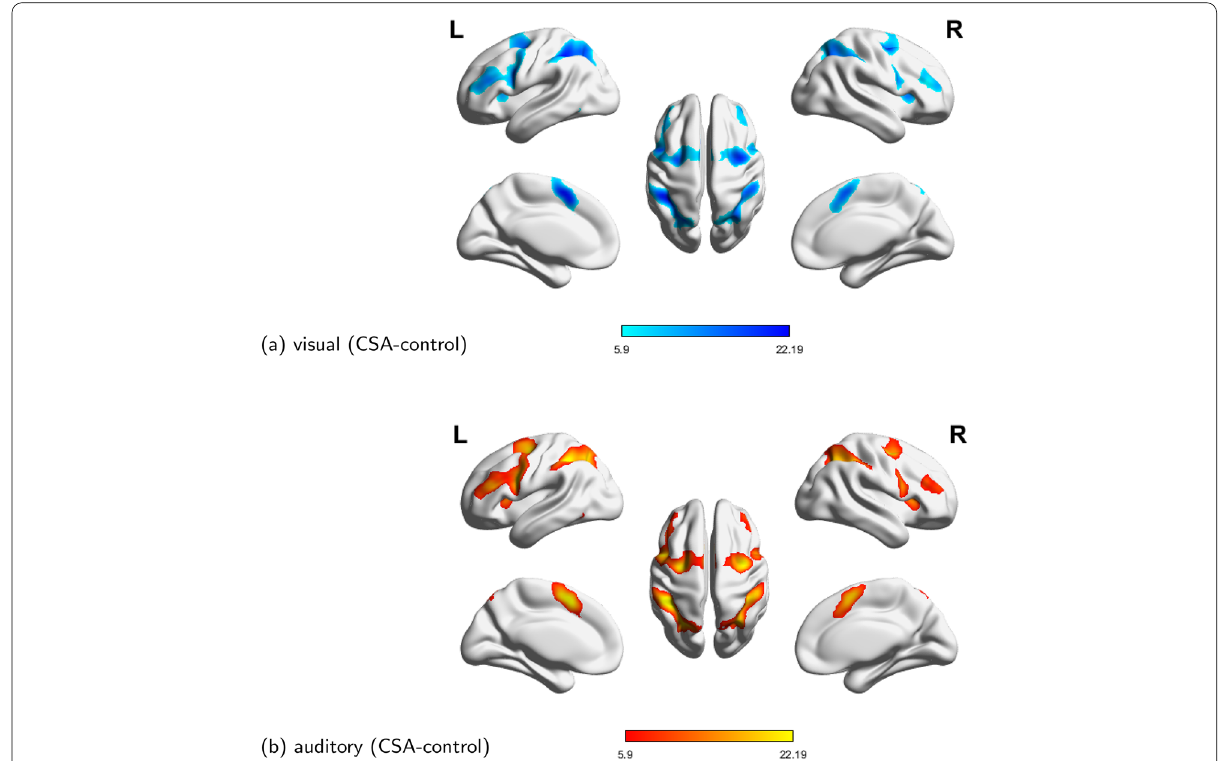
Fig. 4 Mental arithmetic of CSA-control state under the two stimuli (visual and auditory), the activation regions were processed by SPM12. a CSA-control state under visual stimulus. b CSA-control state under auditory stimulus ( P < 0.0001 , uncorrected)